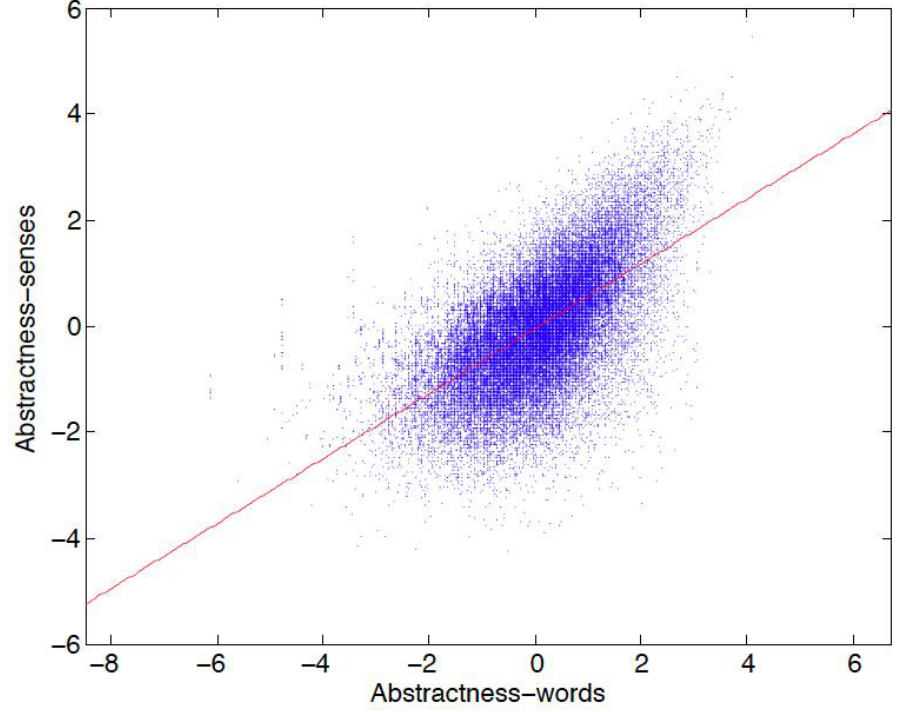
Figure 5. Relation among the two maps of abstractness. The red line shows the linear fit ( y = 0.61 x – 0.052).